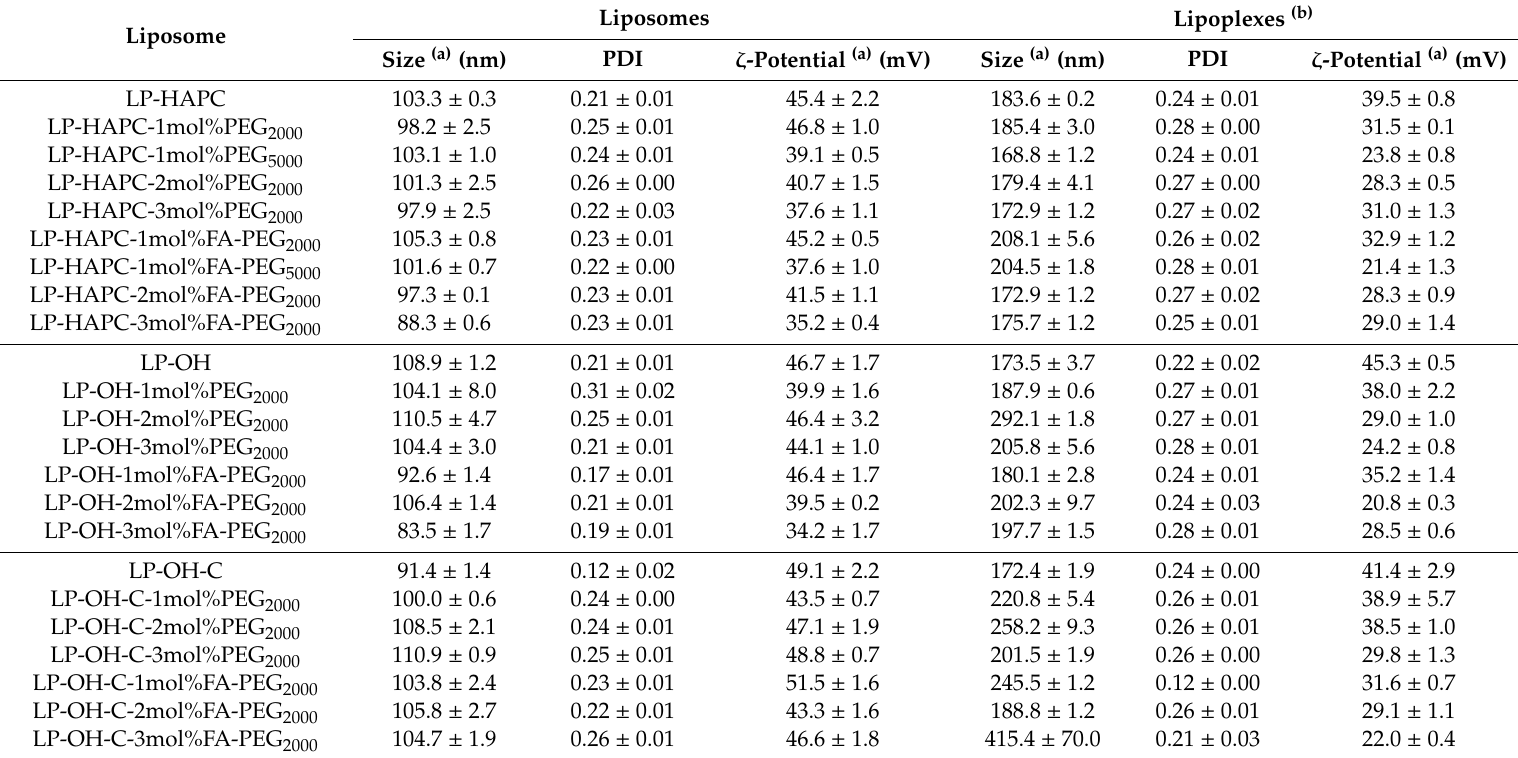
Table 2. Particle size and ζ -potential of cationic liposomes and siRNA